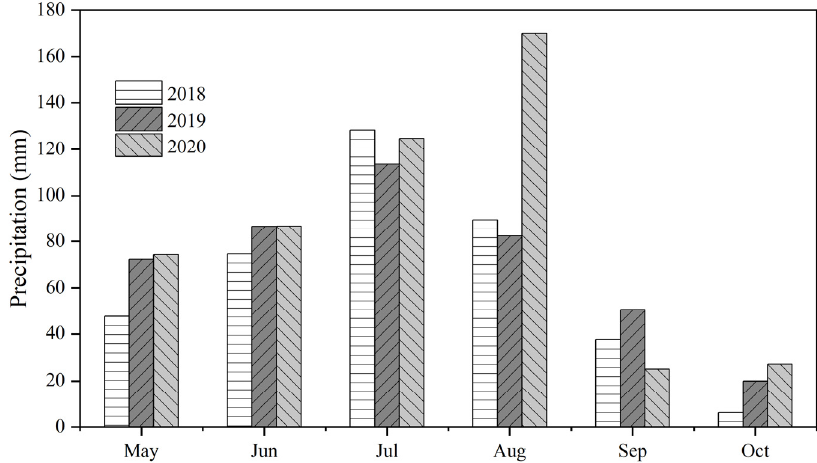
Figure 1. Monthly precipitation during the 2018, 2019, and 2020 study seasons.